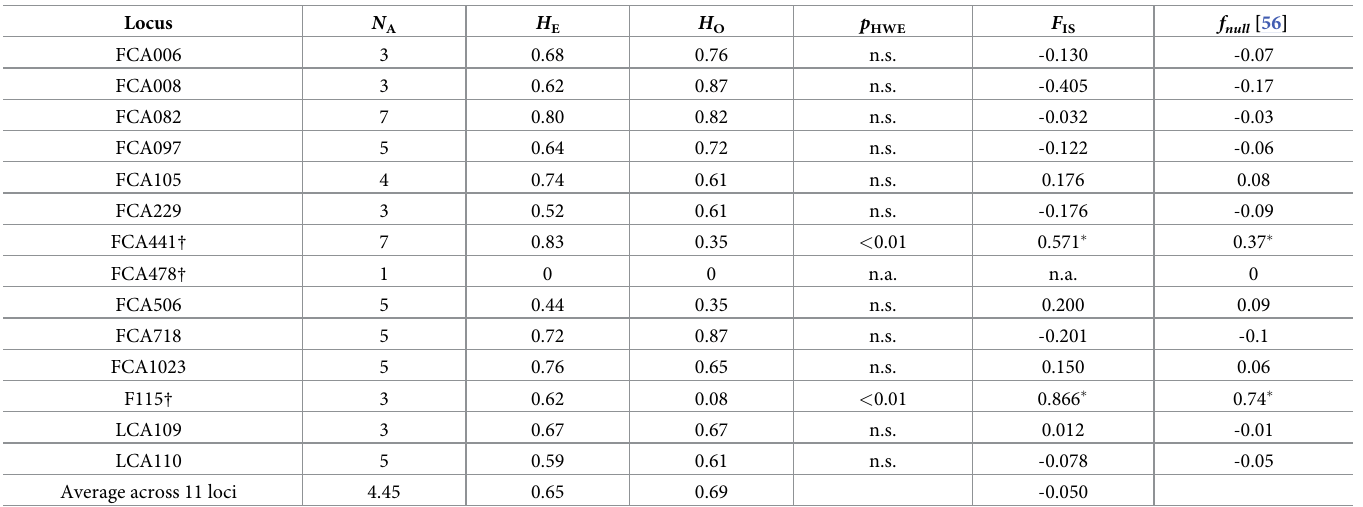
Table 2. Summary of genotyping results at 14 microsatellite loci for north-western Anatolian lynx. Locus N